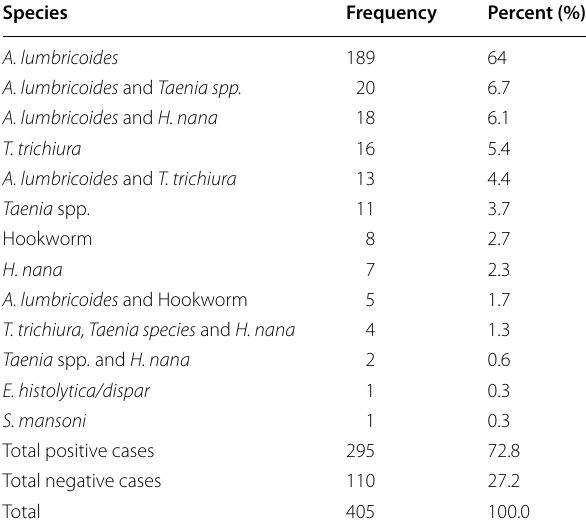
Table 2 Total parasites identified from the study participants, Gedeb District, Gedeo Zone, southern Ethiopia,